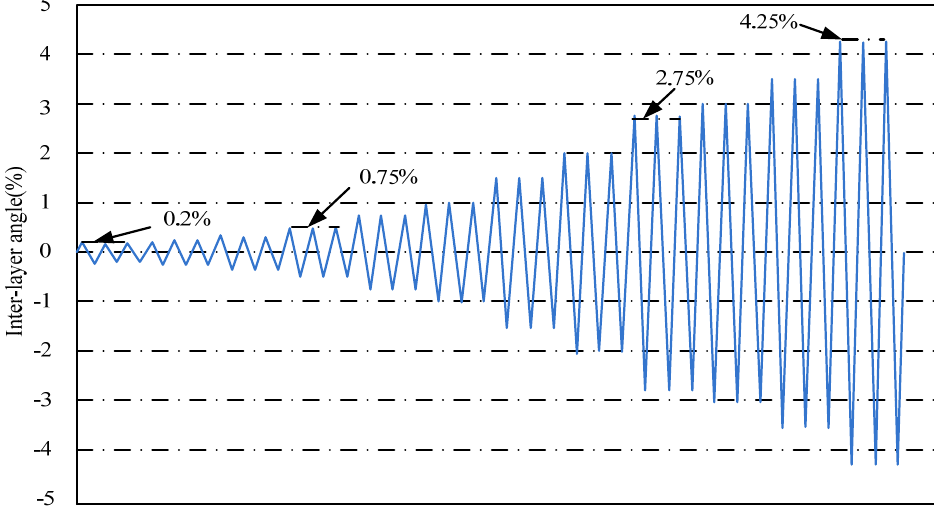
Figure 8. The loading device (unit: mm).